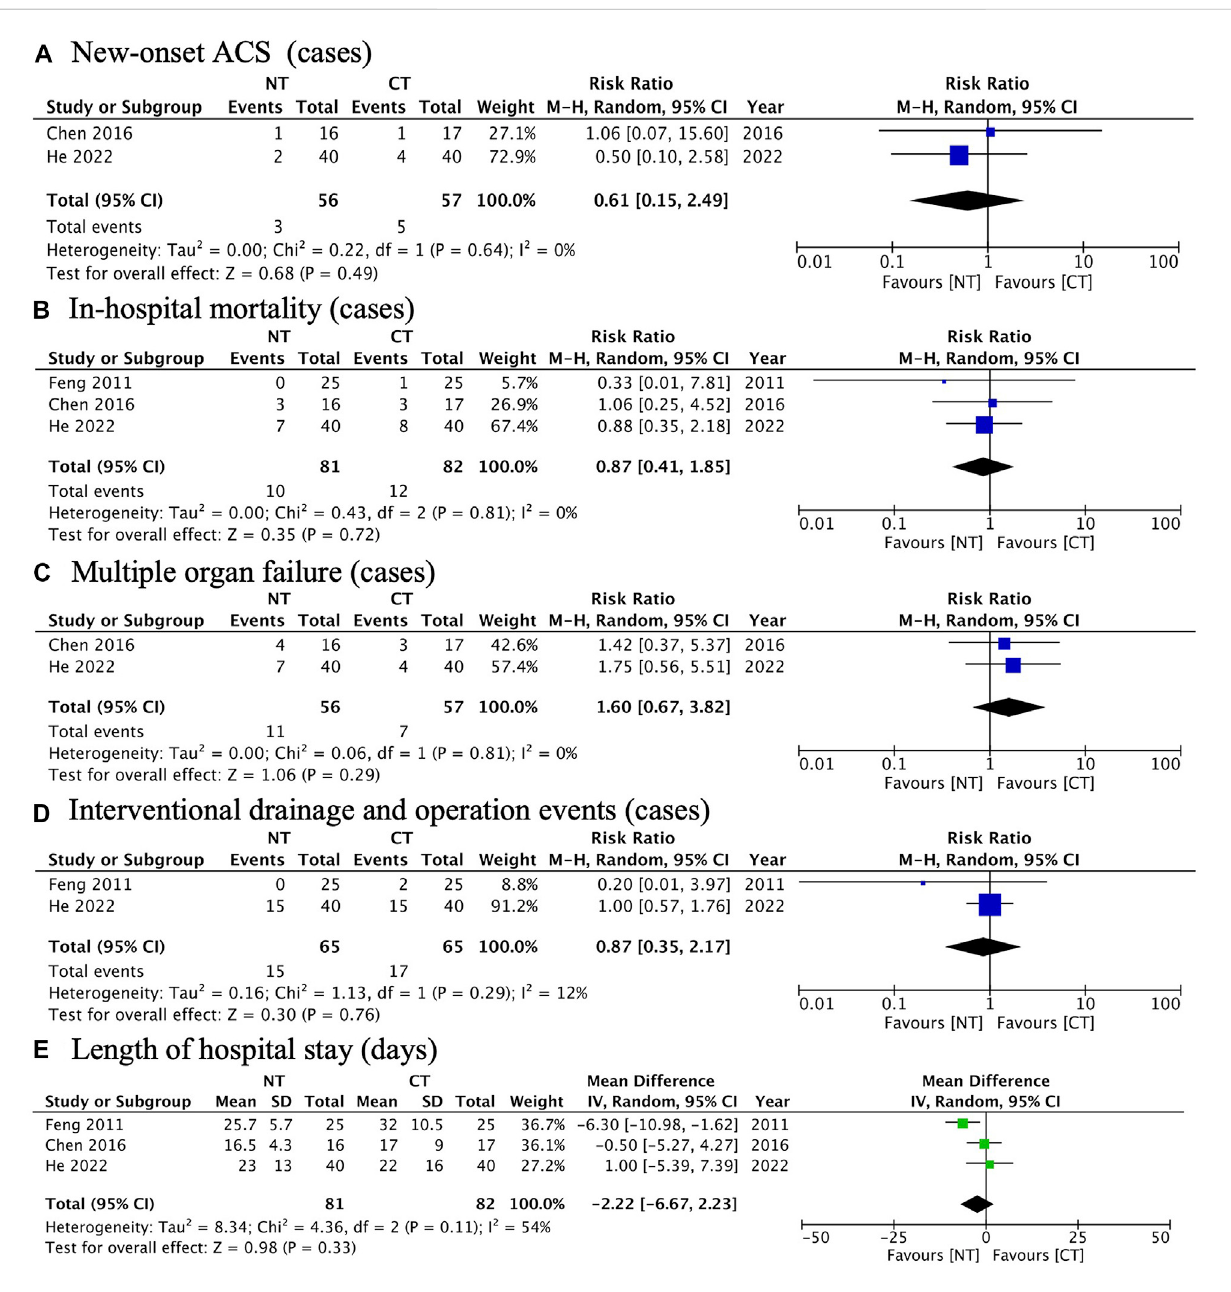
FIGURE 5 Forest plots illustrating other secondary outcomes: (A) new-onset ACS; (B) in-hospital mortality; (C) multiple organ failure; (D) interventional drainage and operation events; (E) length of hospital